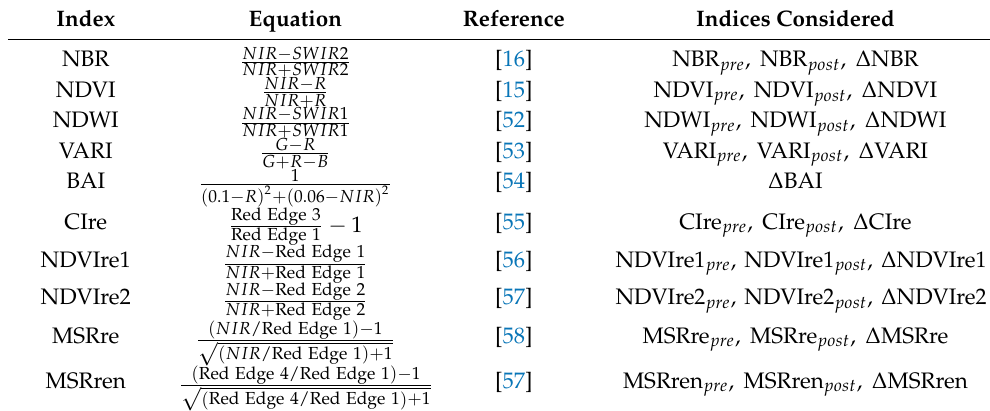
Table 2. The spectral indices used for SI Method in this study. The indices considered for the classification include the pre- and post-fire difference indices (denoted by ∆ ) and the pre- and post-fire indices (denoted by “pre” or